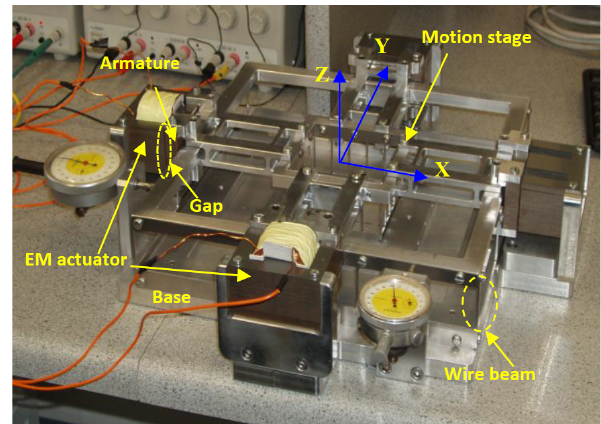
Figure 1. A desktop-size XY compliant parallel manipulator ac- tuated by two EM actuators (where the twisting rotation about the z axis is well constrained by appropriately setting up the ratio of the motion stage size to the wire beam length and making beams distribute around multiple